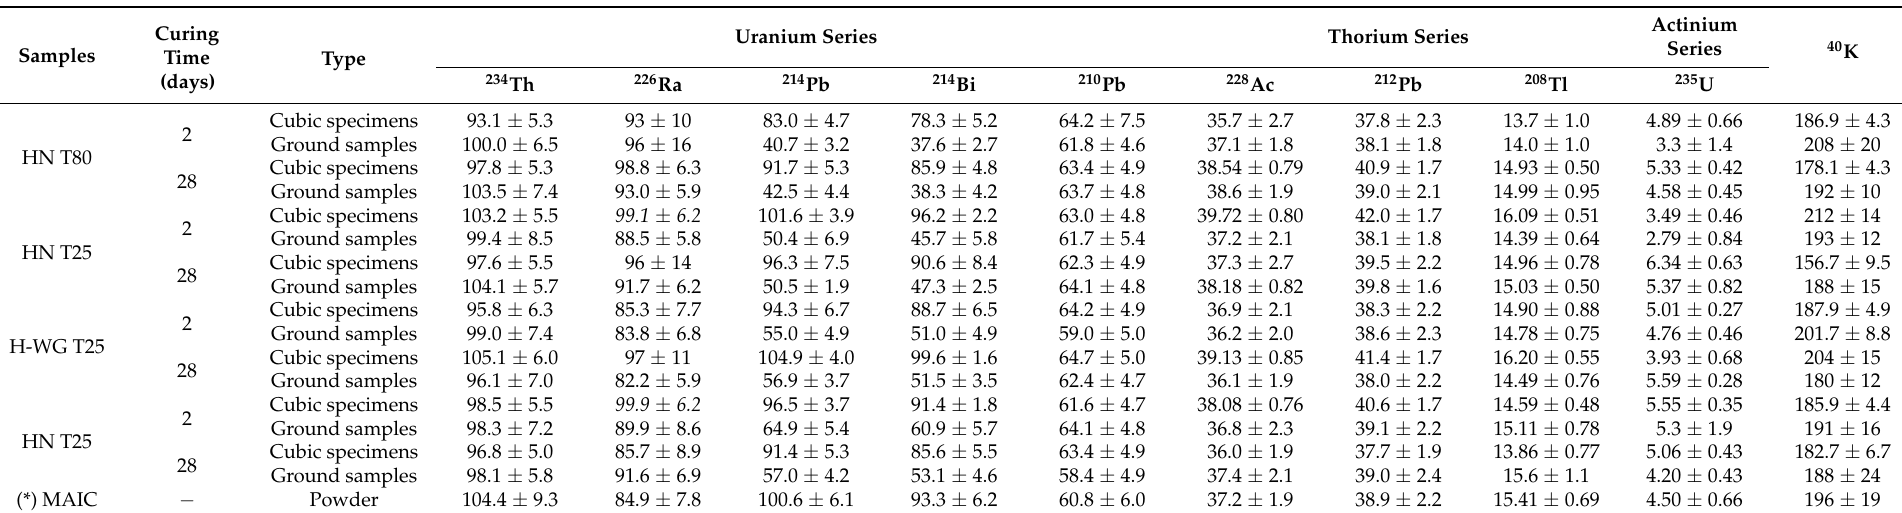
Table 9. Activity concentrations for gamma emitters in the uranium, thorium and actinium radioactive series in the samples.